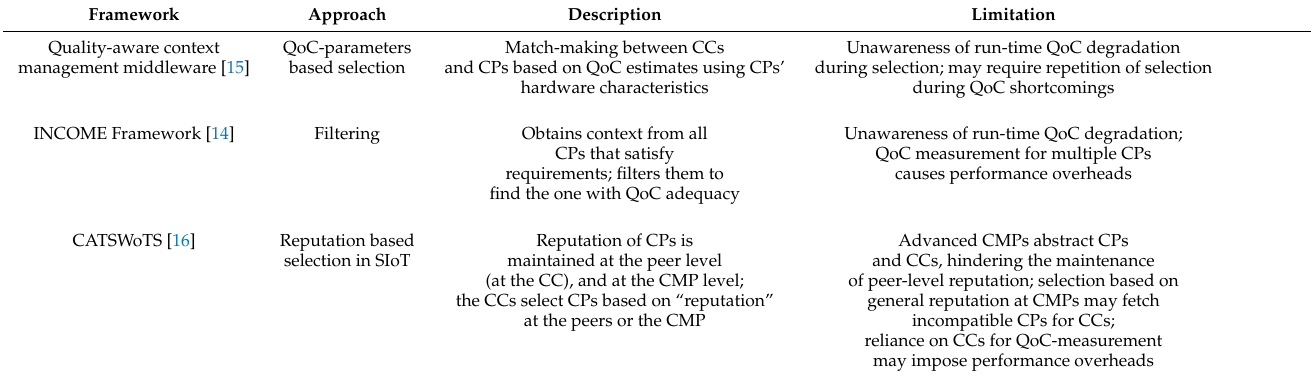
Table 9. Few QoC-aware selection frameworks—along with their selection approaches, description and limitations of these